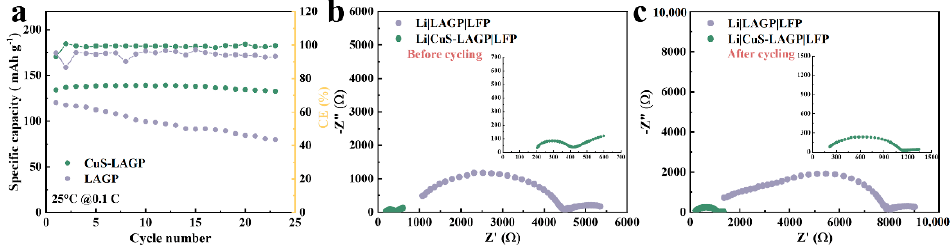
Figure 10. ( a ) Comparison of the cyclic stability of two types of full cells at 0.1 C without a liquid electrolyte. EIS plots of Li|Li 2 S/Cu@LAGP|LFP and Li|LAGP|LFP full cells ( b ) before and ( c ) after cycling for 23 cycles.